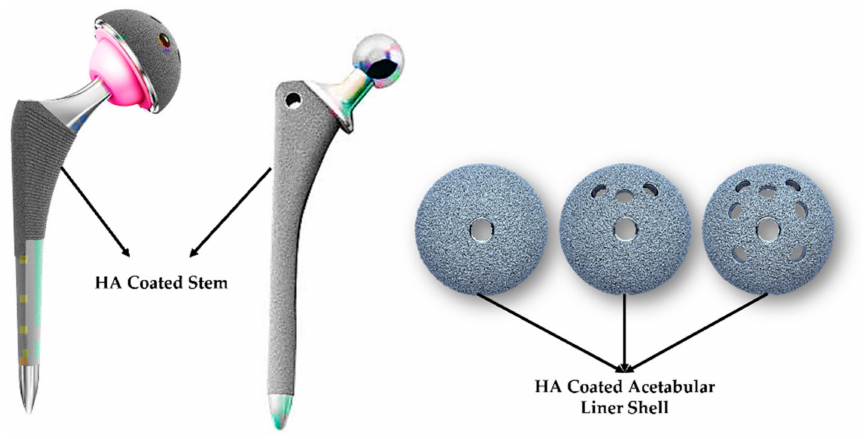
Figure 5. HA-coated hip stem and acetabular liner shell [33,61].